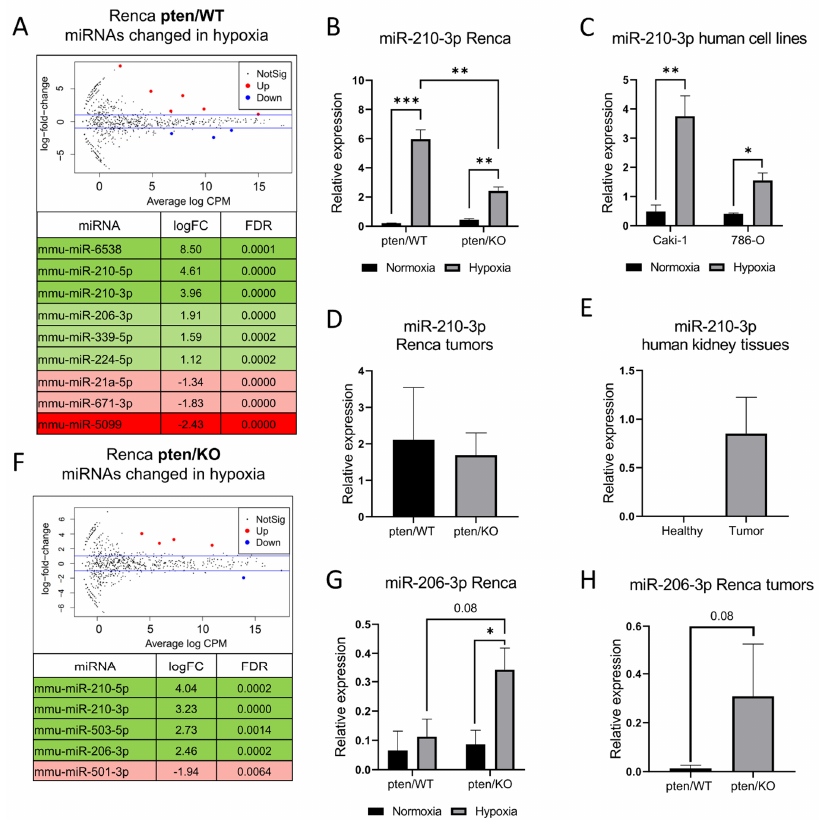
Figure 3. Hypoxia-induced miRNA signature in murine kidney cancer models with different PTEN status ( A ) Volcano plots and list of significantly differentially expressed miRNAs after exposure to hypoxia in Renca pten/WT cells; shades of green represent miRNA upregulated in hypoxia; shades of red downregulated in hypoxia ( B ) Relative to miR-25-3p and miR-16-5p expression of miR-210- 3p in cells cultured in normoxic and hypoxic condition: Renca pten/WT and pten/KO ( C ), Caki-1 and 786-O ( D ) Relative to miR-25-3p and miR-16-5p expression of miR-210-3p in tumors derived from Renca pten/WT and pten/KO cells ( E ) Relative to miR-25-3p expression of miR-210-3p in hu- man tissues from healthy kidney and kidney cancer ( F ) Volcano plots and list of significantly differ- entially expressed miRNA after exposure to hypoxia in Renca pten/KO cells ( G ) Relative to miR-25- 3p and miR-16-5p expression of miR-206-3p: in Renca pten/WT and pten/KO cultured in normoxia and hypoxia ( H ) in the tissues from Renca pten/WT and pten/KO tumors, Student’s t-test *** p -value < 0.001; ** p -value < 0.01; * p -value < 0.05.